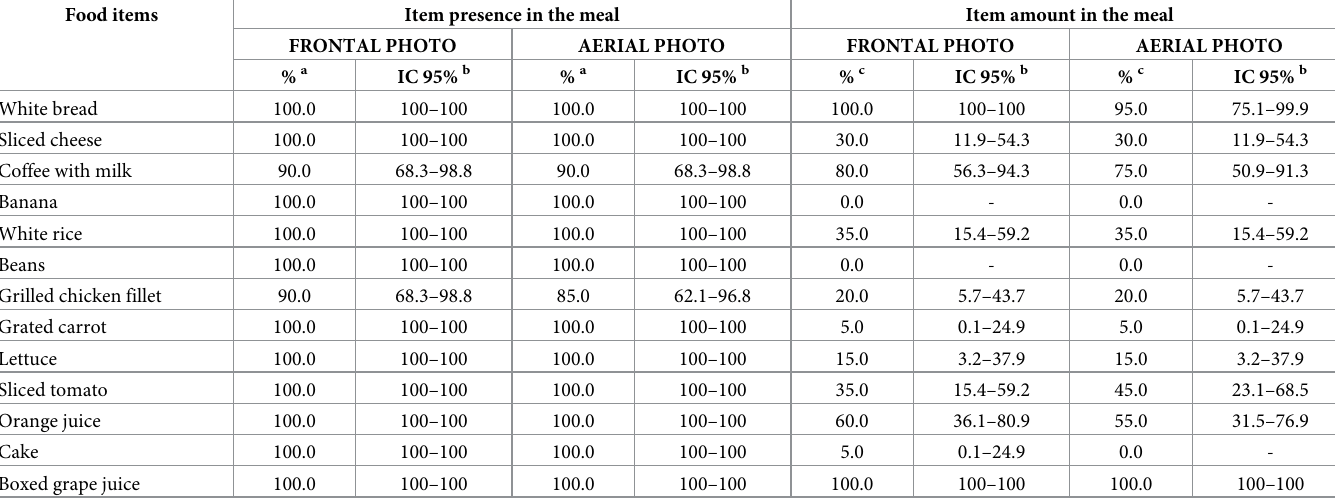
Table 1. Experts’ correctness in the evaluation of the meals. Natal, Rio Grande do Norte, Brazil -2019.